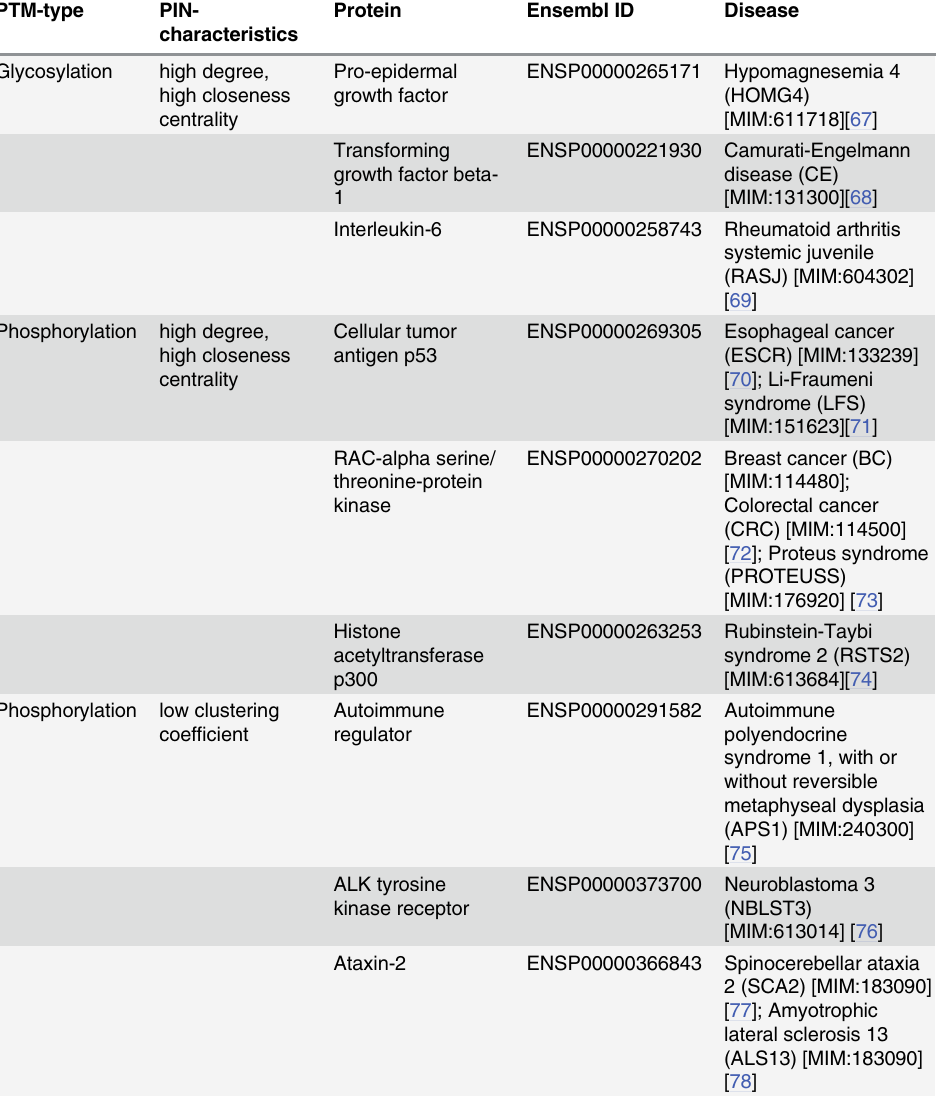
Table 4. Examples of human PTM-carrying proteins with characteristic PIN-properties and their known disease